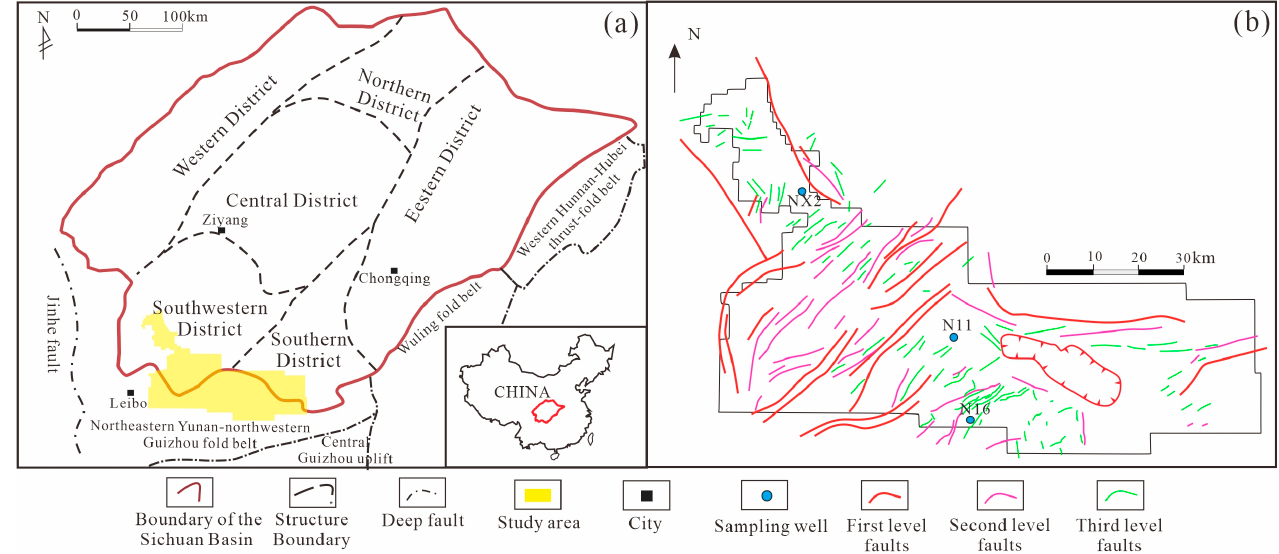
Figure 1. Regional tectonic profile ( a ) and well locations ( b ) of the Sichuan Basin and the Changning gas field.